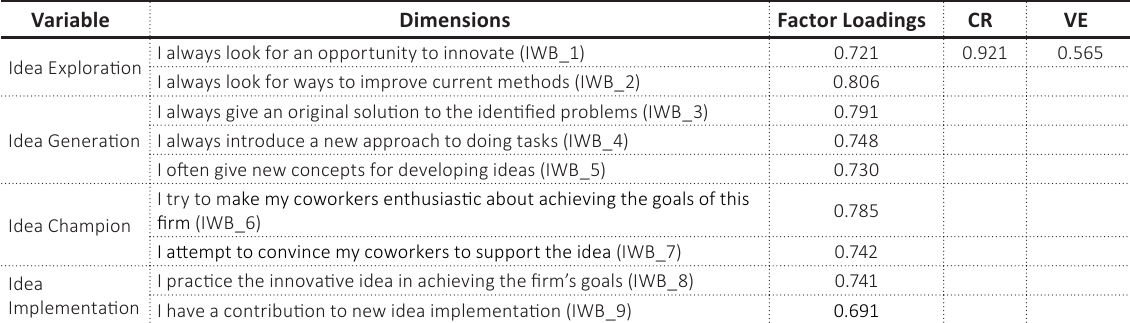
Table 2 (cont.). Multidimensional measurement model